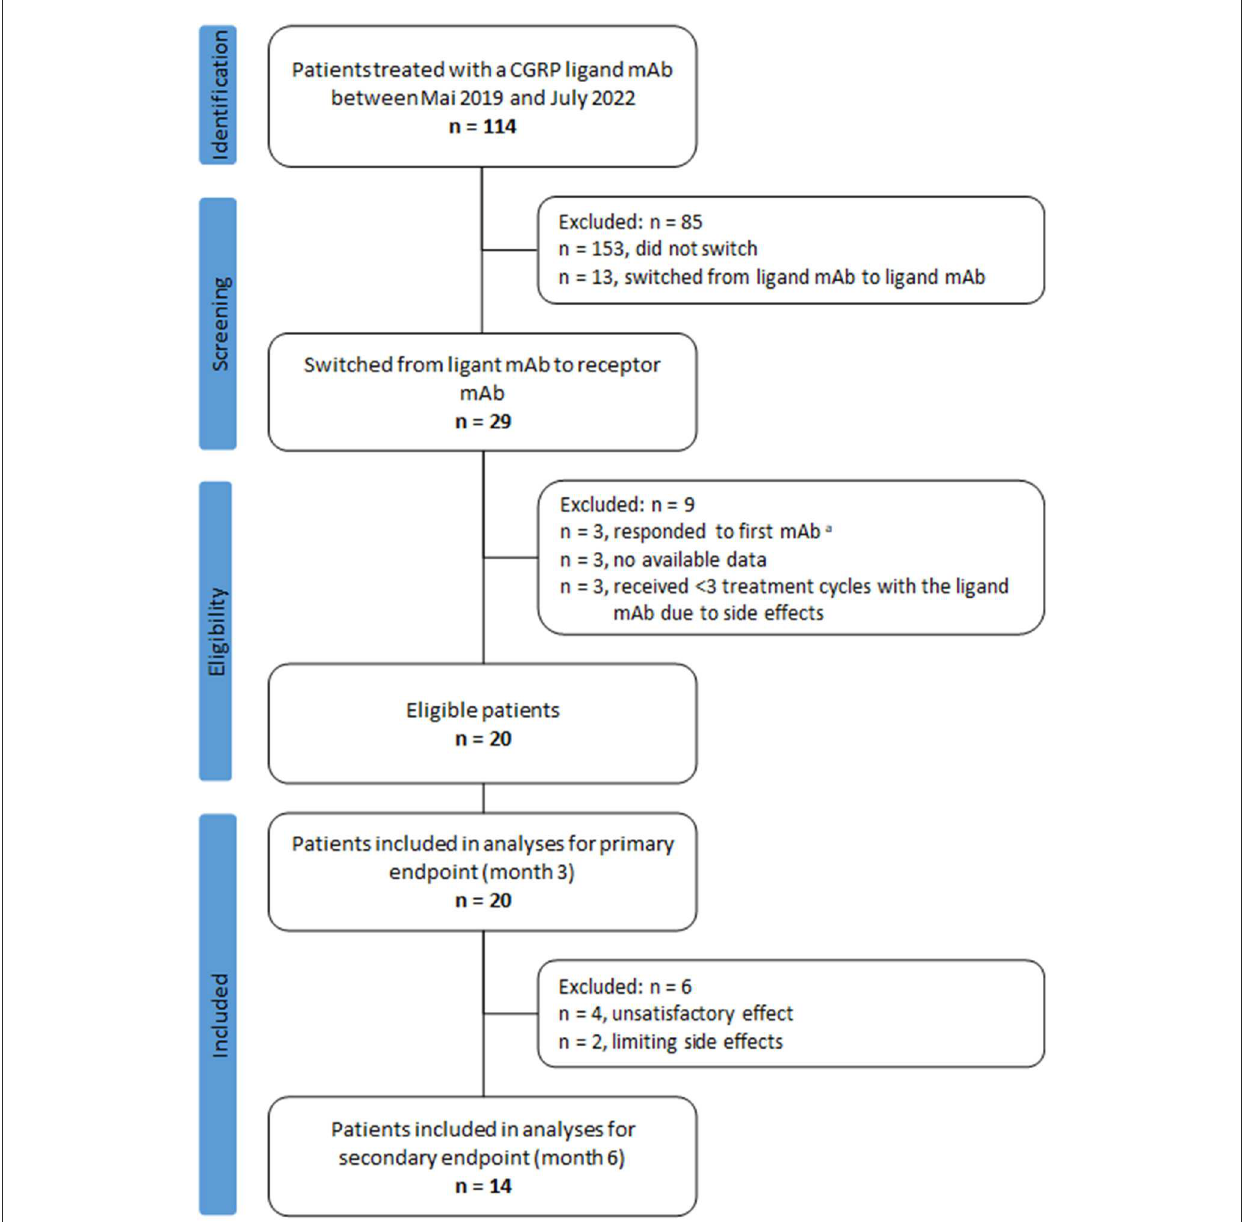
FIGURE1 Flow chart of patient selection. a Response defined as a ≥ 30% reduction of monthly headache days during month 3 of treatment with the CGRP ligand mAb compared to the month before treatment initiation.